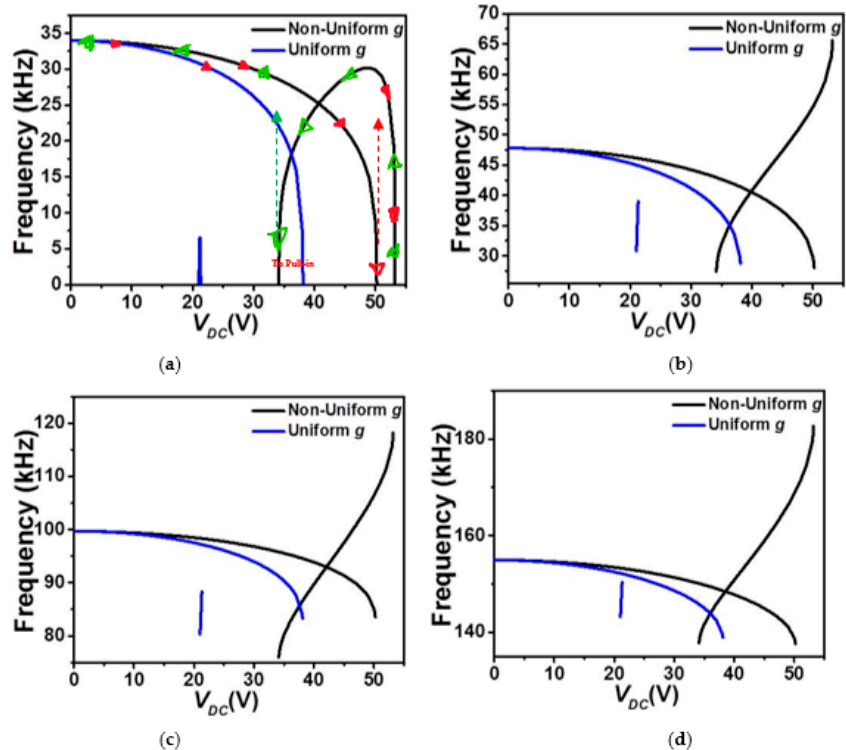
Figure 5. The variation of the ( a ) first, ( b ) second, ( c ) third, and ( d ) fourth in-plane flexure natural frequencies for Case 1 as varying V DC and for uniform and non-uniform air-gaps ( g ).